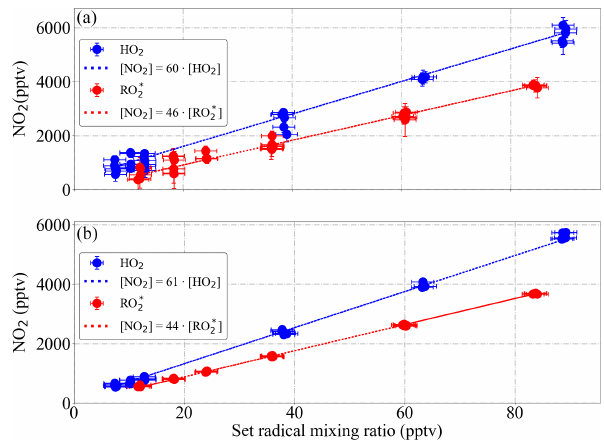
Figure 15. Determination of the effective absorption cross section ( σ NO ) from the measurement of mixtures of known concentration 2 of NO 2 in synthetic air. Values obtained for the PeRCEAS detec- tors: AB (red), FH (blue) and FR (green) at 200mbar are indicated in the plot. Linear fits are also shown by dashed lines. 0 . 3 × 10 − 19 and 6 . 4 ± 0 . 3 × 10 − 19 cm 2 molec. − 1 for the AB,